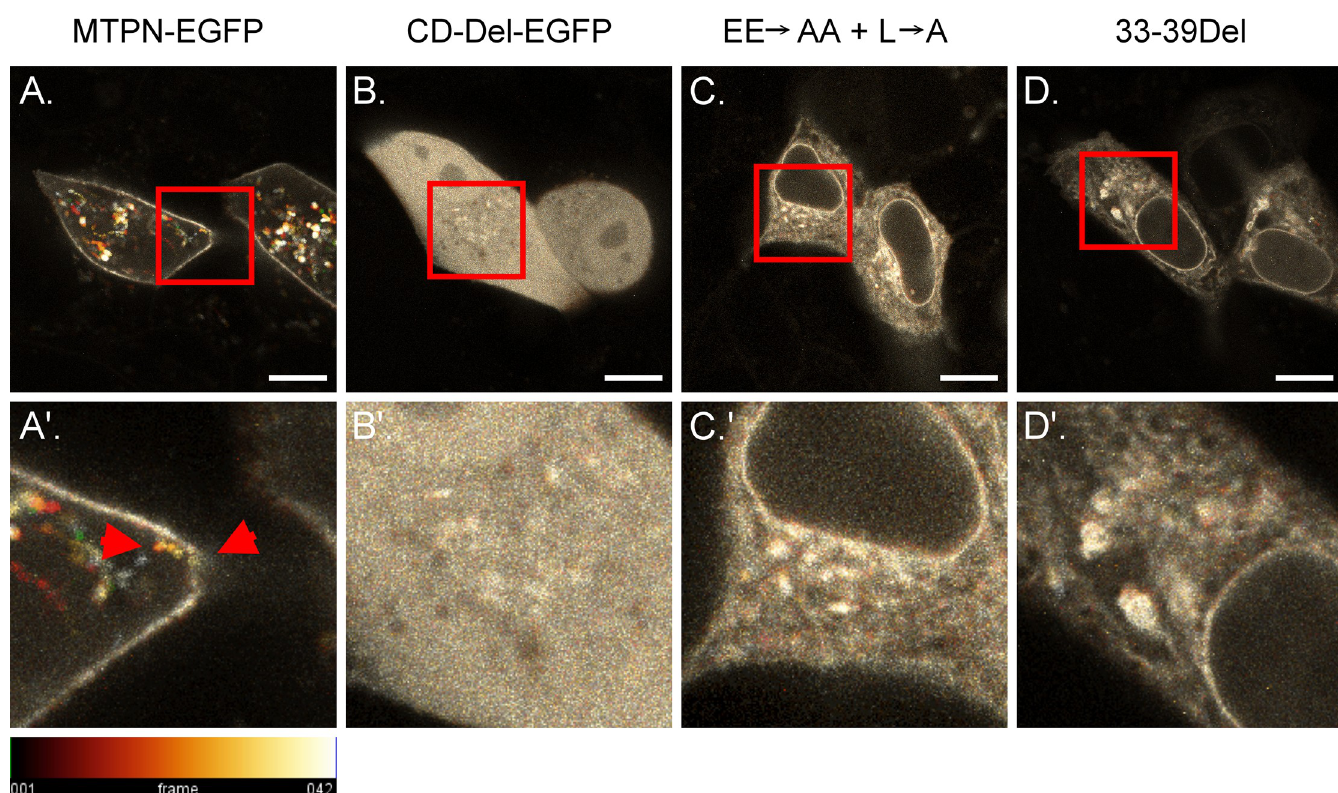
Fig 6. Monoleucine sorting motif mutants lose subcellular polarity and are retained in the ER/Golgi secretory pathway. Polarized MDCK cells transiently expressing the MTPN-EGFP, CD-Del-EGFP, and the monoleucine sorting motif mutants, the EE ! AA+L ! A and 33-39Del, as indicated, were cultured on glass- bottom dishes and imaged live at 37C o 5% CO 2 by laser scanning confocal microscopy. Forty (40) seconds of footage are presented using temporal-color indexing. A vesicle containing MTPN-EGFP was observed fusing with the membrane as indicated by the trail of color transitioning from orange to white, as indicated by the two red arrowheads. Bar, 10 μ